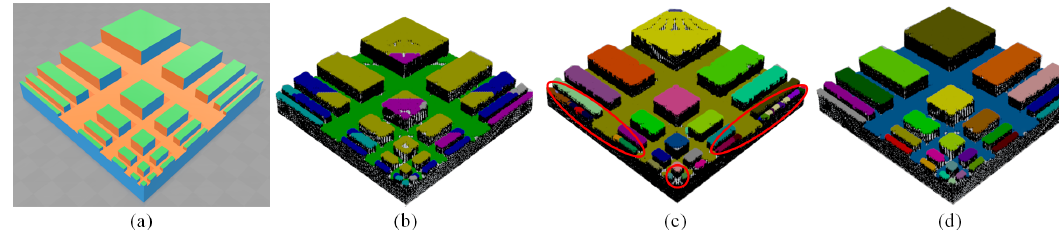
Figure 1. ( a ) A synthetic scene in Gazebo where a pattern object (detailed described in Section 3.3) was perceived by a simulated RGB-D sensor, yielding the point cloud to whom three plane extraction methods were applied, as depicted in ( b – d ). ( b ) Sloped results produced by RANSAC, note that points labeled with the same color belong to the same plane. ( c ) Under- and over-segmented results (marked with red ellipses) produced by Region Growing method. ( d ) Results produced by the proposed method. Best viewed in online color